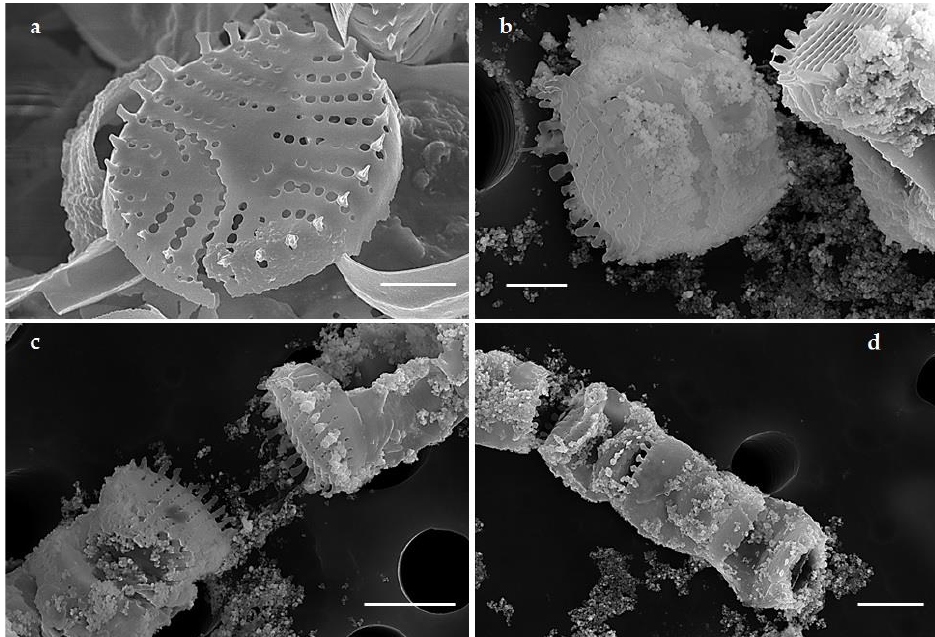
Figure 4. SEM images showing surface morphology of control ( a ) and silver treated ( b – d ) frustules of G. flavovirens and confirmed the extracellular deposition of nanoparticles in aggregated forms [scale bar 1 µm]. Materials 2021 , 14 , x FOR PEER REVIEW